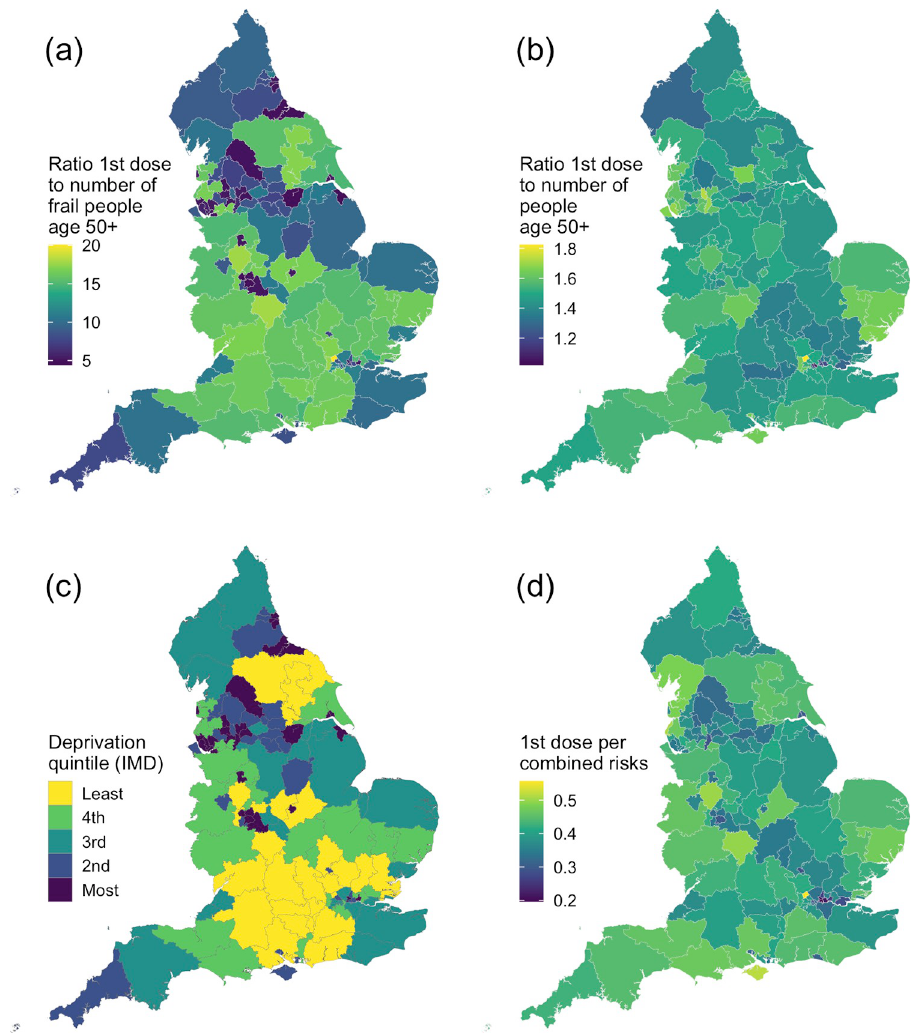
Fig 1. Vaccination doses relative to the prevalences of COVID-19 risk factors in England. (a) Ratio of the number of first dose of COVID-19 vaccines administered to the estimated number of frail people over age 50, for each Clinical Commissioning Group area in England. (b) Ratio of the number of first dose of a COVID-19 vaccine administered to the estimated number of people over age 50, for each Clinical Commissioning Group area in England. (c) Area deprivation quintile (measured by English Index of Multiple Deprivation). (d) Ratio of the number of first dose of a COVID-19 vaccine administered to the number of diagnoses for each of seven risk factors associated with adverse COVID-19 outcomes. These risk factors are atrial fibrillation, chronic kidney disease, a learning disability, obesity, smoker and former smoker. They do not include frailty or pre-frailty. Note that this is the total number of diagnoses; a person with multiple risk factors will be counted multiple times for the ratio’s